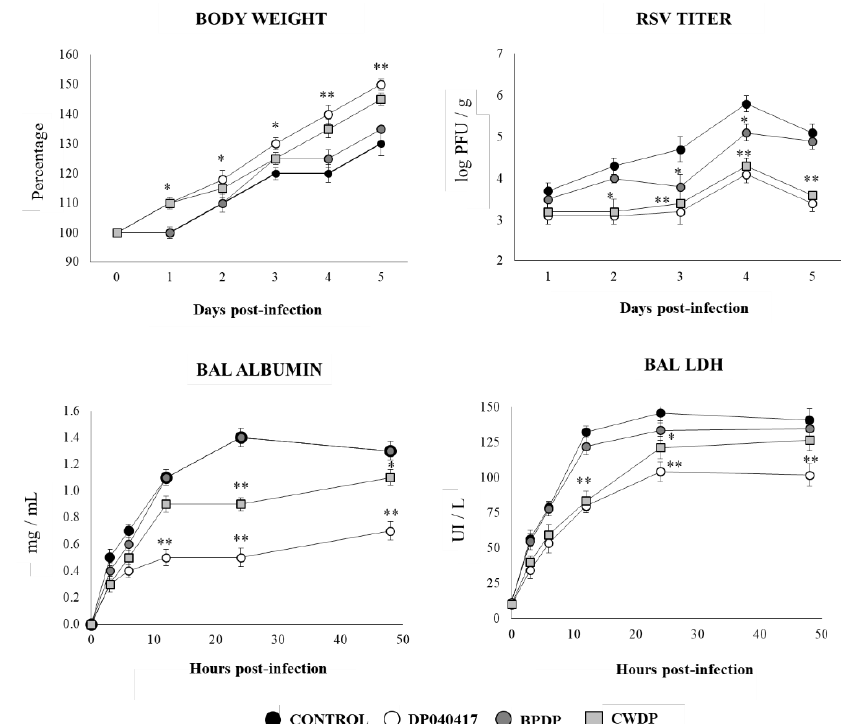
Figure 10. Effect of Dolosigranulum pigrum 040417 on the resistance to Respiratory Syncytial Virus (RSV) infection. Infant mice were nasally primed with viable (DP), bacterium-like particles (BPDP), or cell wall (CWDP) from D. pigrum 040417 during five consecutive days and then challenged with RSV. Non-treated infant mice challenged with the viral pathogen were used as controls. Lung RSV titers, changes in body weight, and lactate dehydrogenase (LDH) activity and albumin concentrations in broncho-alveolar lavages (BAL) were evaluated on different time points after the viral challenge. Experiments were performed with 5 – 6 mice per group per each time point. The results represent data from three independent experiments. Significantly different when compared to control at the same time point * p < 0.05 or ** p < 0.01.